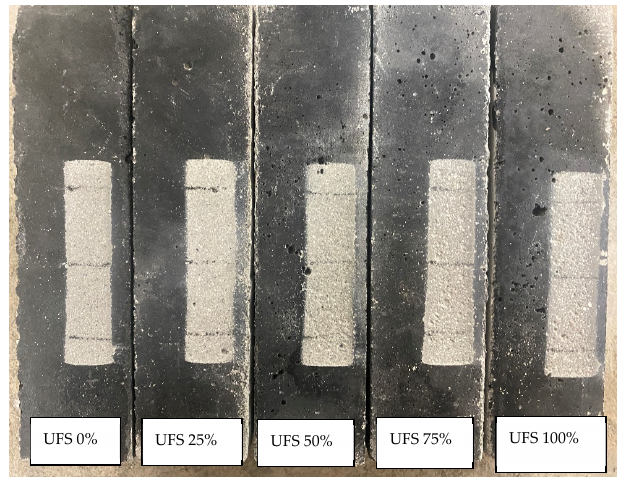
Figure 19. Examples of the specimen surface after the wear resistance tests.